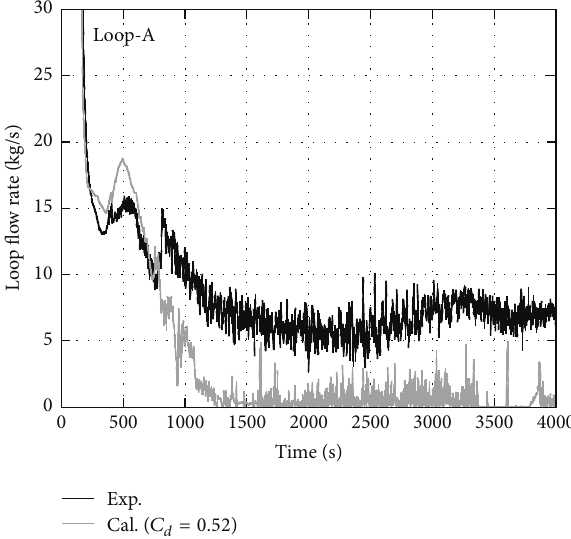
Figure 12: LSTF and RELAP5 results for primary loop flow rate in loop-A in case of release of dissolved gas.